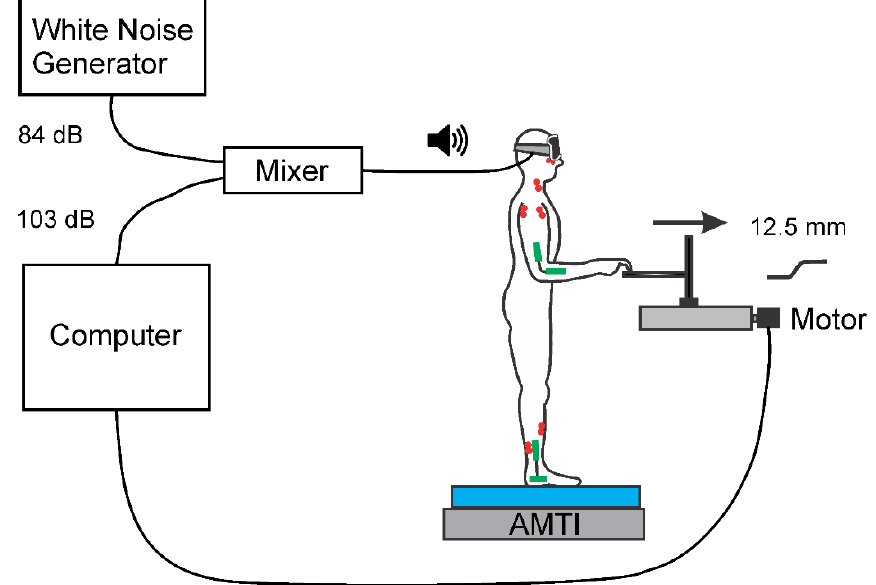
Figure 1. Schematic of the experimental set-up. Participants stood on foam atop a force plate, while lightly (<1N vertical load) touching a plastic touch plate. During DISPLACEMENT trials, the touch plate was unexpectedly translated away from the participant with the use of a computer controlled stepper motor. During STARTLE trials, the computer generated a startling tone delivered to the participant via a pair of indwelling earphones. During COMBINED trials, the touch displacement and startling tone were triggered simultaneously by the computer. In all conditions, the participant received white noise to mask the sound of the operating motor. Electromyographic (EMG) (red), goniometers (green), and center of pressure were used to characterize the evoked responses.